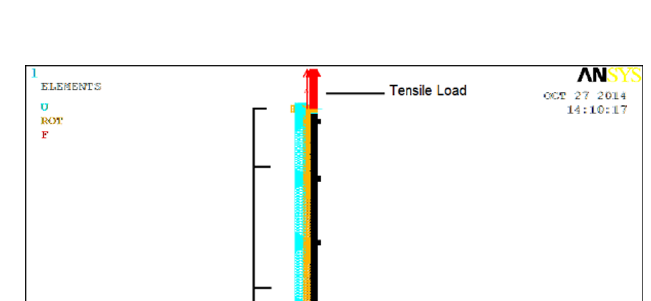
The thickness of guide thimble and grid, 0.5 mm and 0.3 mm, respectively, are de fi ned by giving real constants values. The material properties of guide thimble and spacer grid used in the present FE analysis are given in Table 2.